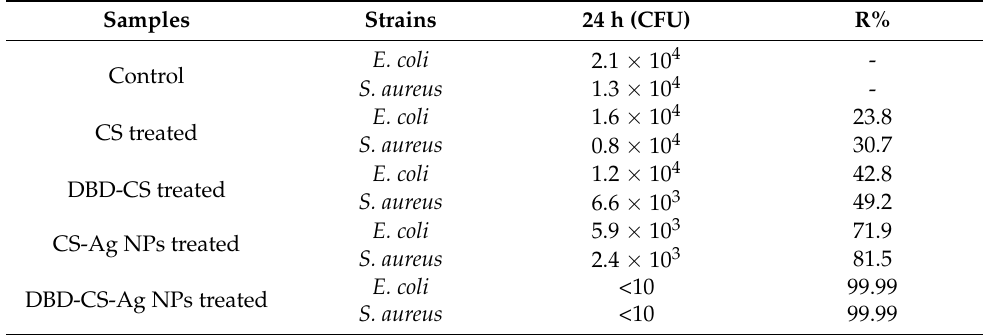
Figure 8. Photographs of inhibition zone of PLA nonwoven fabrics: ( a ) CS-Ag NPs treated ( E. coil ); ( b ) CS-Ag NPs treated ( S. aureus ); ( c ) DBD-CS-Ag NPs treated ( E. coil ); ( d ) DBD-CS-Ag NPs treated ( S. aureus ). Table 2. Reduction percent of bacteria according to the GB/T 20944.3-2008 standard